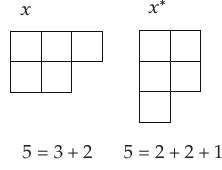
Figure 5: The Young diagram x and its dual diagram x (cid:2)